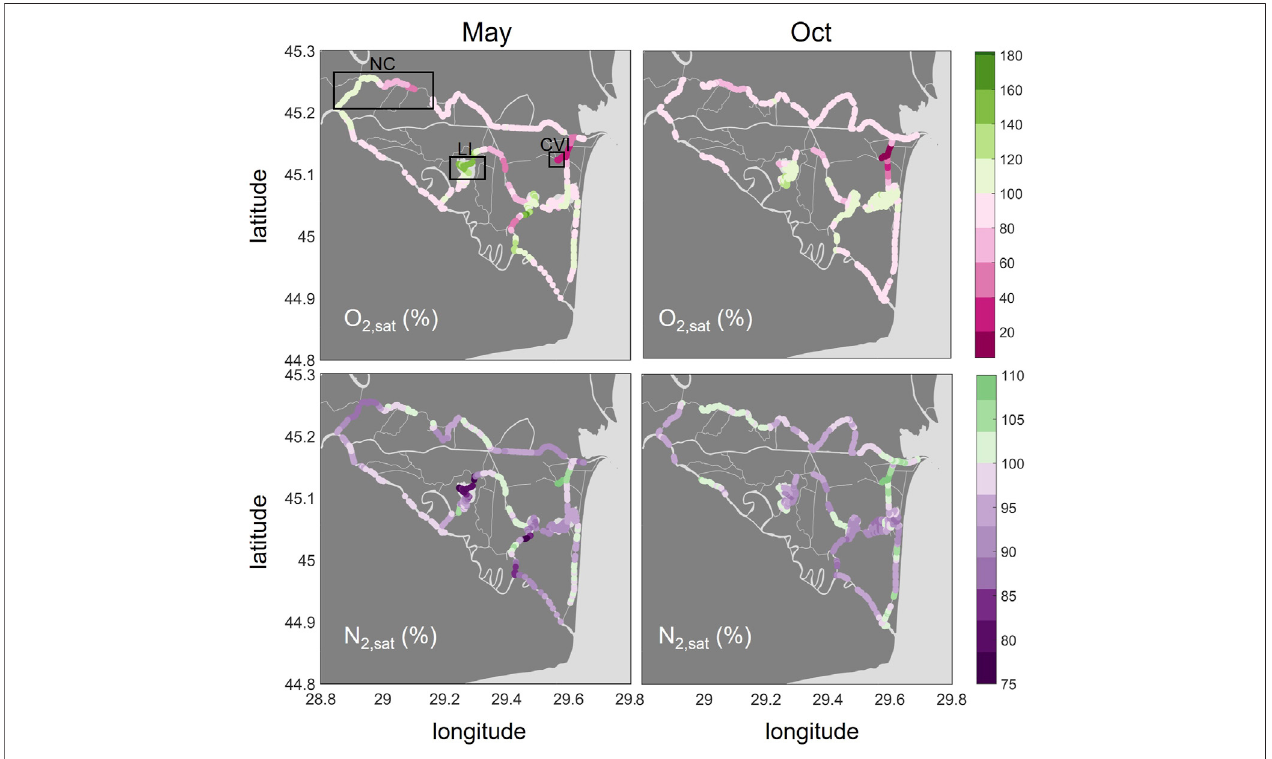
FIGURE5| SpatialdistributionofO 2 (toprow)andN 2 (bottomrow)in%saturationsinMayandOctober2017.Oversaturationisshowningreen,undersaturationin purple and pink. Please note the different ranges of the colorbars. The boxes in the upper left graph indicate the locations of the Northern Channels (NC), Lake Isac (LI) and Canal Vatafu-Imputita